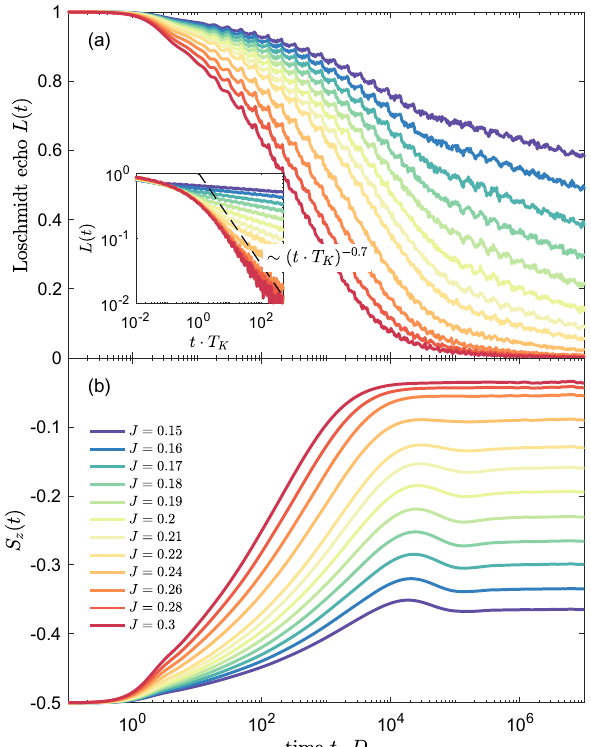
Figure 8. ( a ) The Loschmidt echo L ( t ) and ( b ) impurity’s spin expectation value for quantum quench in the coupling strength J 1 = J 2 ≡ J , starting from J = 0 to the value shown in the legend in the presence of external magnetic field B z = 4 · 10 − 5 . The inset in ( a ) presents L ( t ) plotted as a function of t · T K . The other parameters are the same as in Fig.